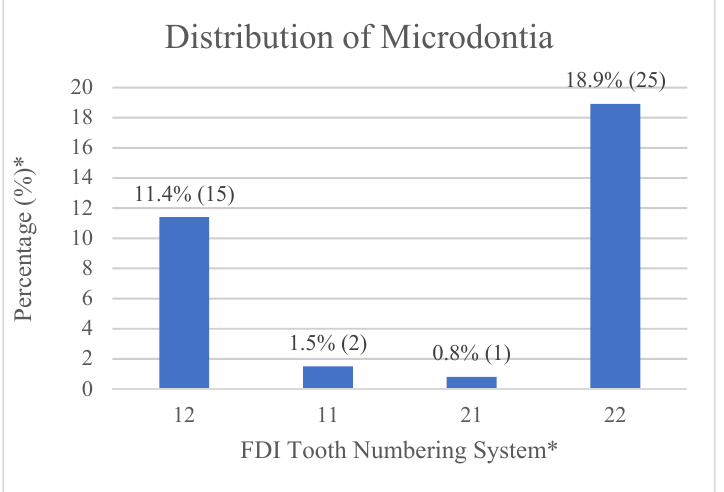
Figure 2. The distribution of microdontia. * (1) Tooth numbering is according to the Fédération Dentaire Internationale (FDI) tooth numbering system for maxillary and mandibular dentition. (2) Percentage of microdontia (number of each tooth site/total patient number (132)). (3) Numbers of microdontia for each tooth site are listed in the parentheses. (4) The third molars are not examined in this study.